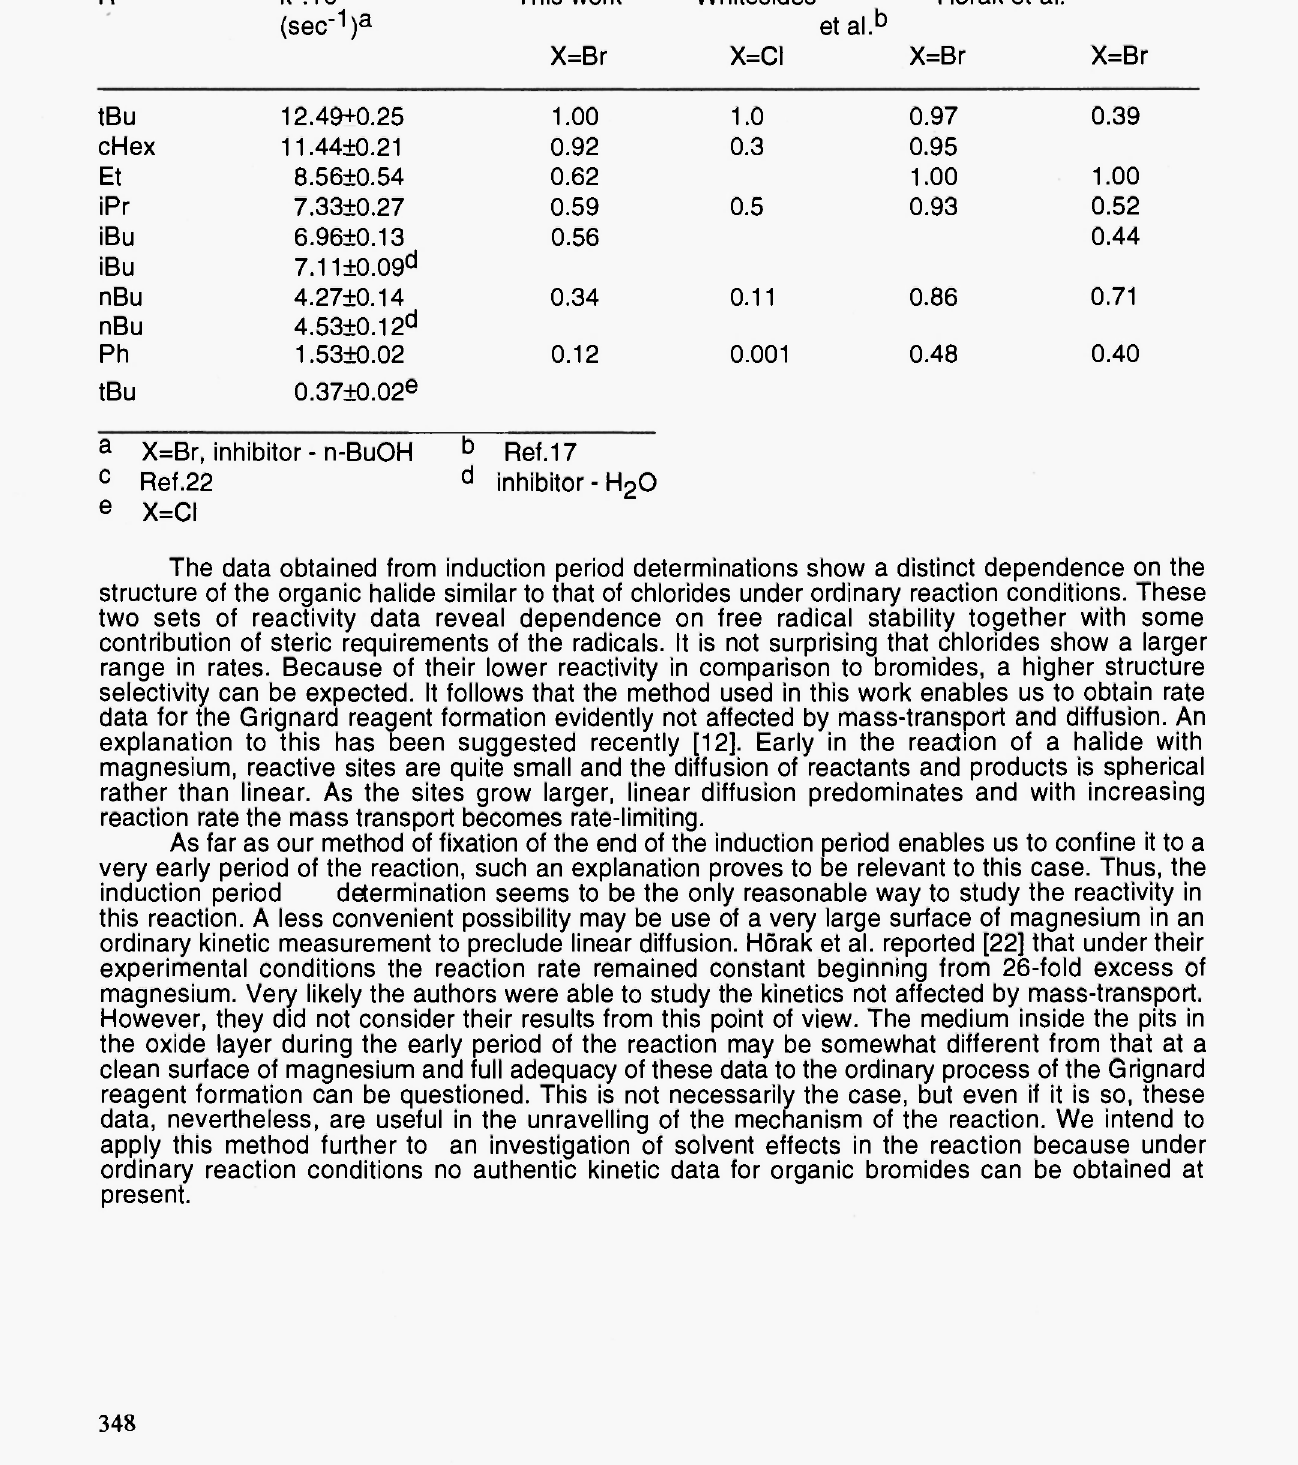
Intrinsic Initiation Constants, k*, from Induction Period Measurements and Relative Rate Constants of Grignard Reagent Formation from RX in Diethyl Ether Relative rate